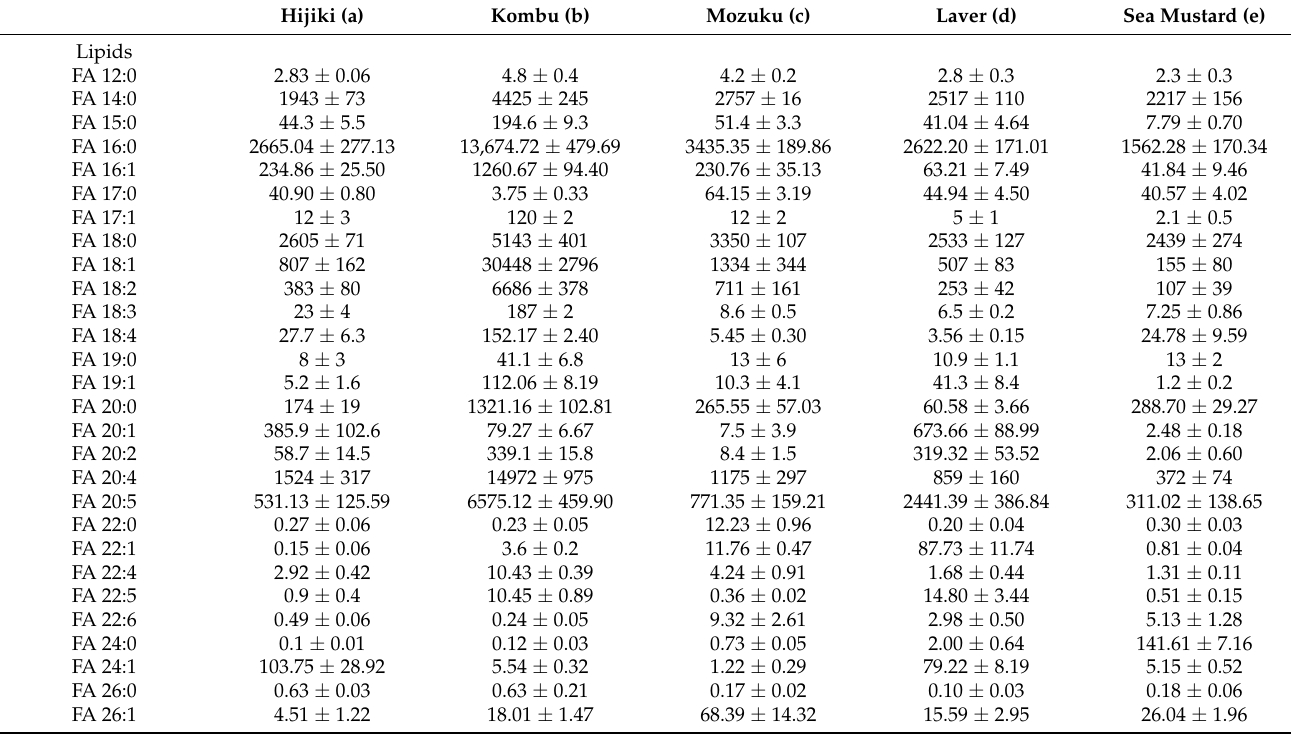
Table 1. Relative amount ( µ g/g) of free fatty acids including PUFAs detected in five species of seaweed. The data were shown as mean ± SD ( n = 3). Two-way ANOVA with Tukey’s multiple comparisons test was applied and a value of p < 0.05 is considered to be statistically